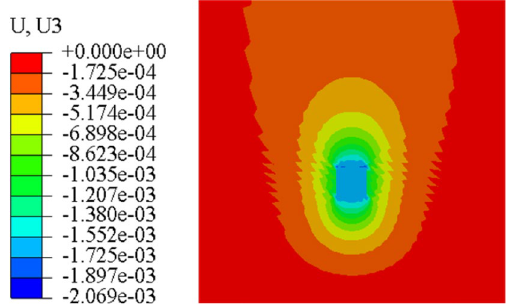
Figure 26. Top 1000 mm, bottom 1000 mm anchor pier stress nephogram.